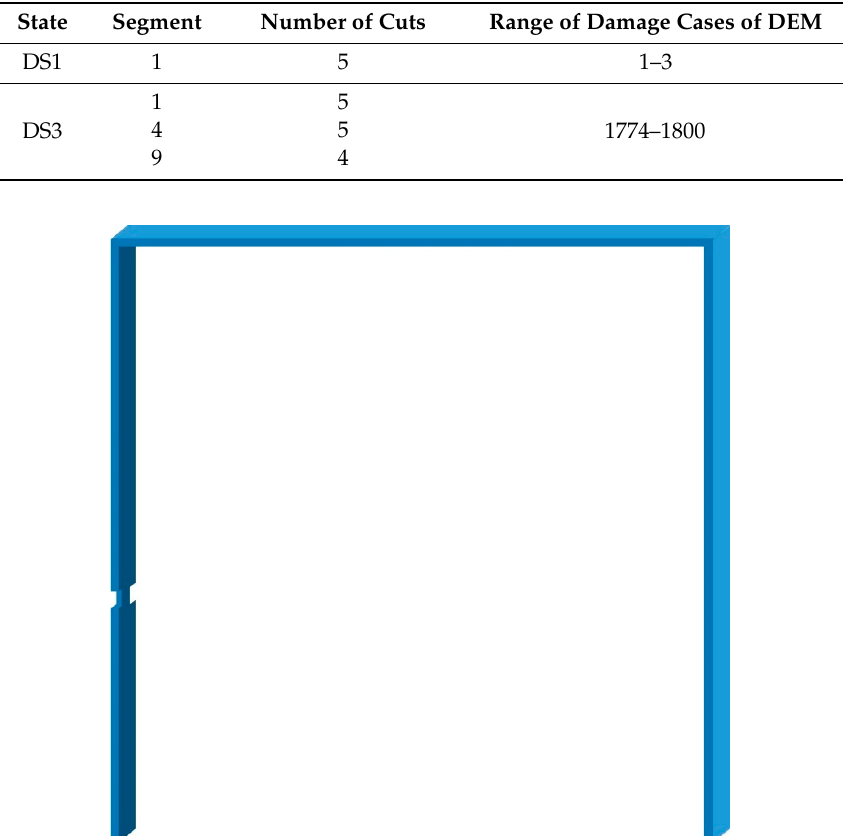
Figure 6. Example of a saw cut [45]. Table 6. GA results: elastic modulus (E DSx ) and damage severities 1 of damaged segments (GPa, %).